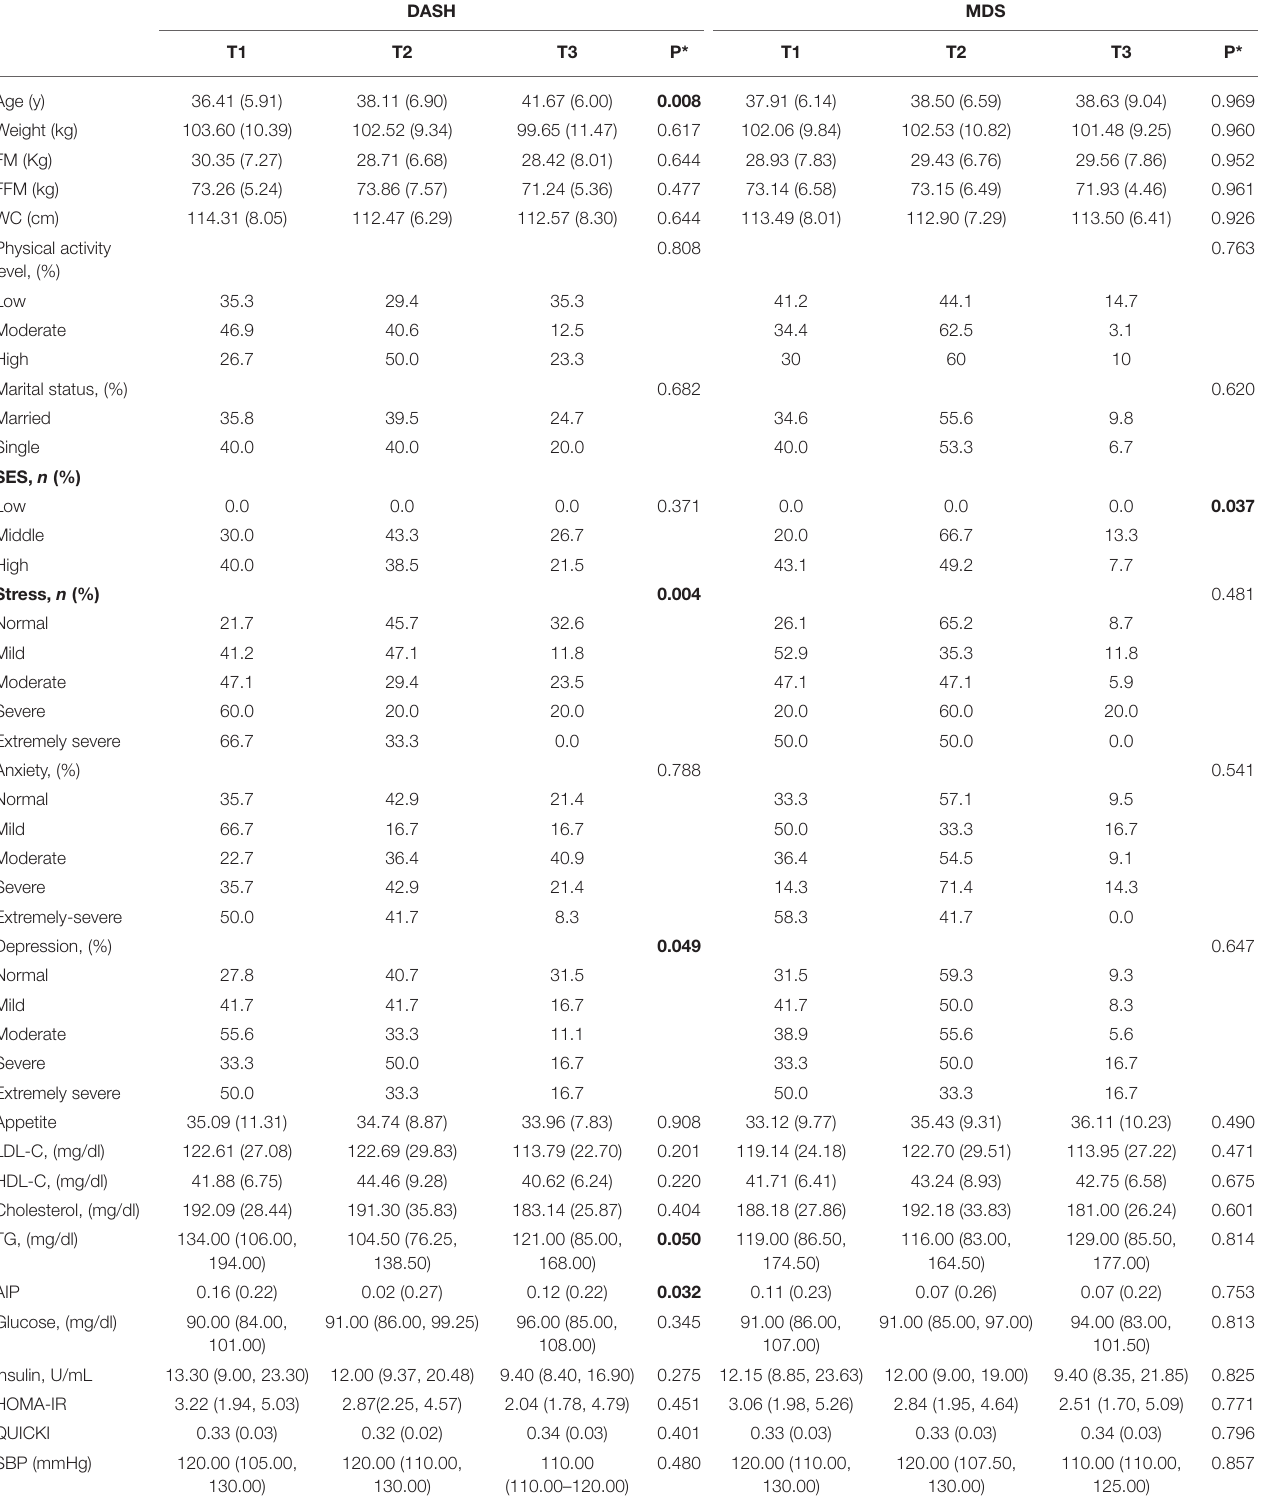
TABLE 3 | Socio-demographic and anthropometric characteristics and cardio-metabolic risk factors according to the tertiles of dietary quality indices in men.